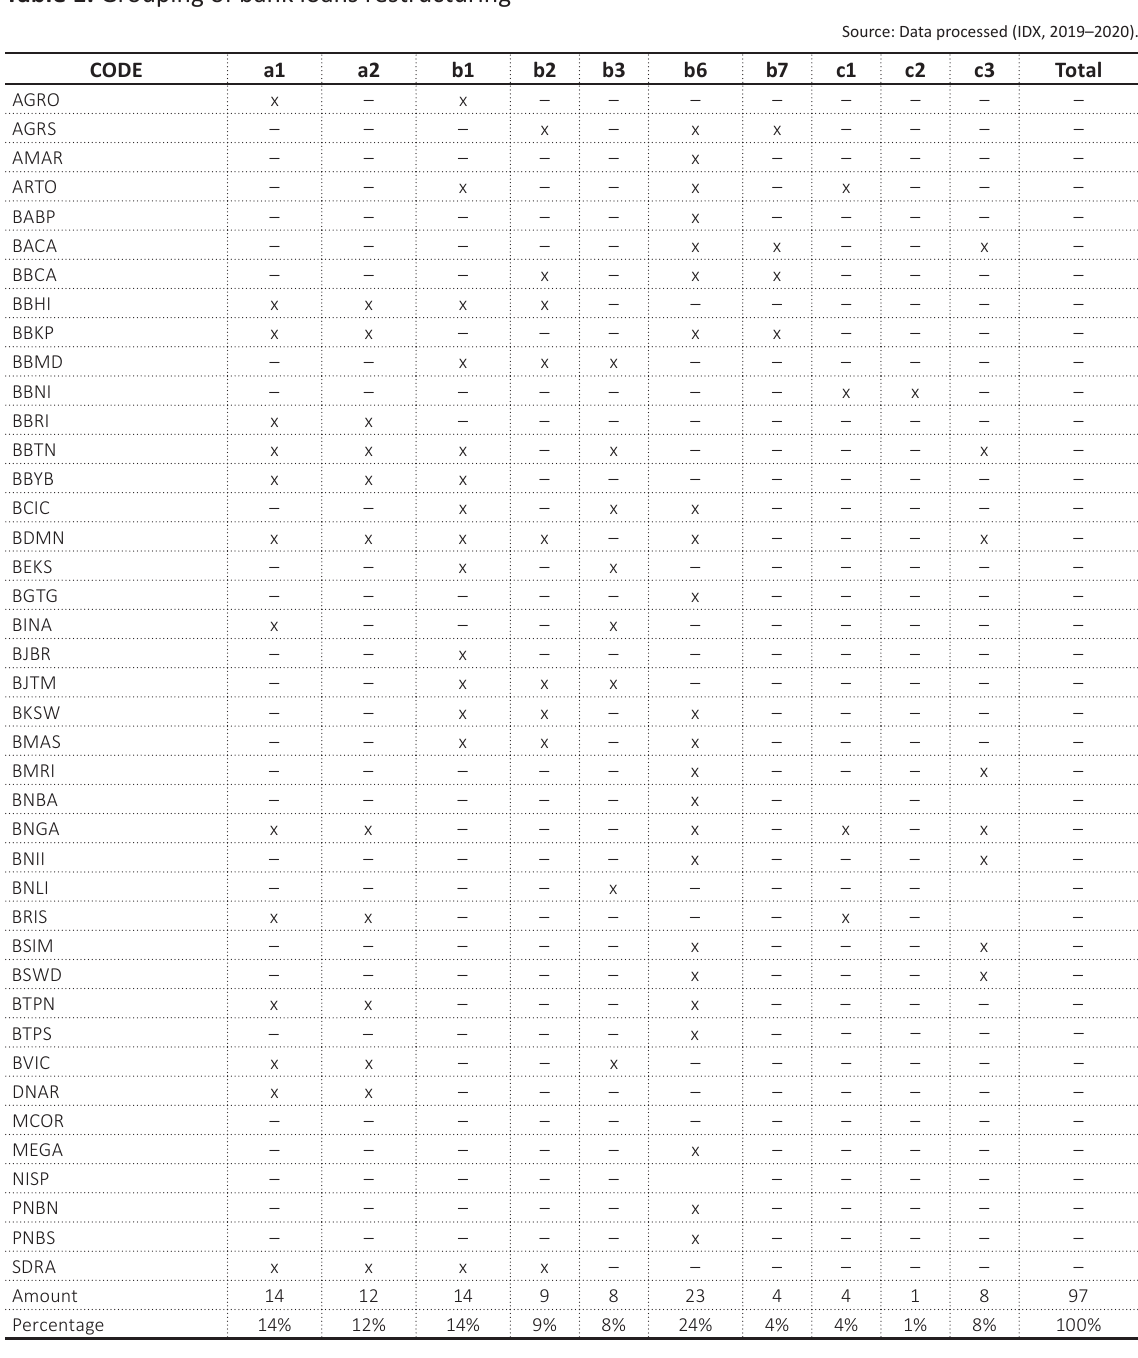
Table 1. Grouping of bank loans